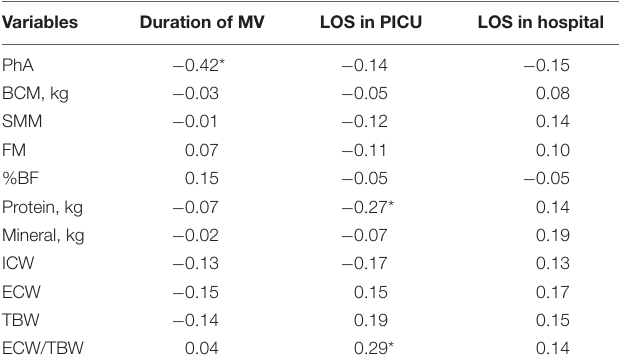
TABLE 3 | Spearman’s correlation coefficients between BIA measurements and clinical outcomes among all admitted